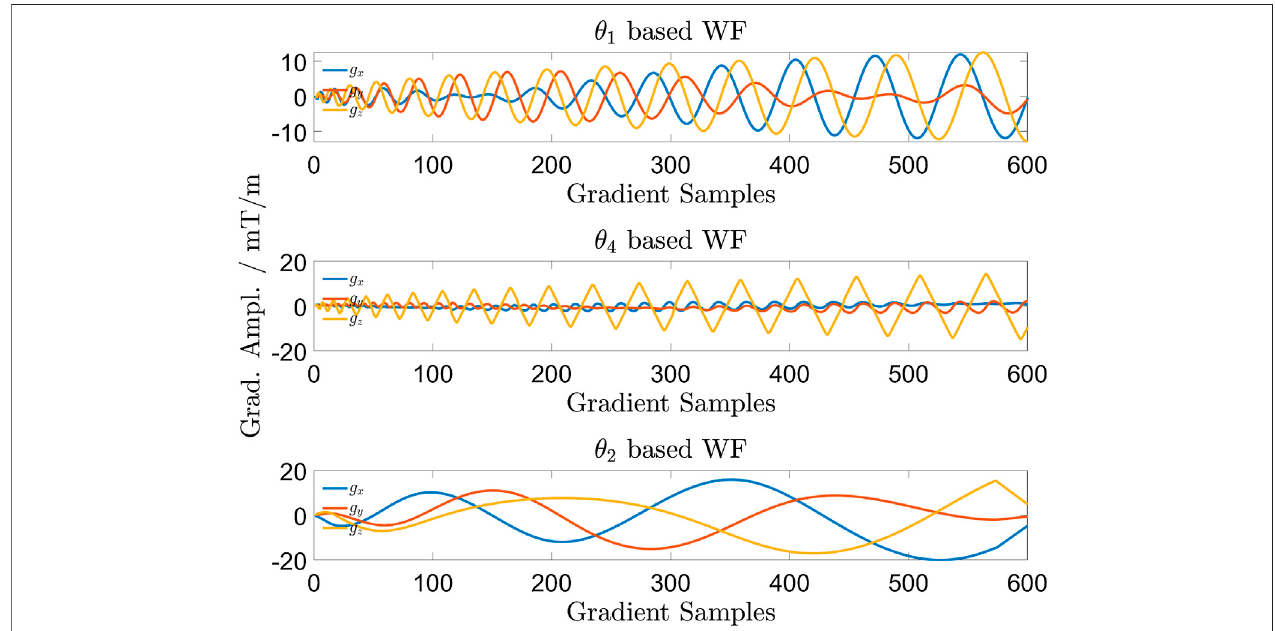
FIGURE2| Allgradientchannelsofoneinterleaveofthethreetrajectoriesshownin Figure1 .Duetodifferentinterleavelengths,the fi rst600pointsofeachgradient waveform are shown. The θ 2 based gradient waveform refers to 1d).